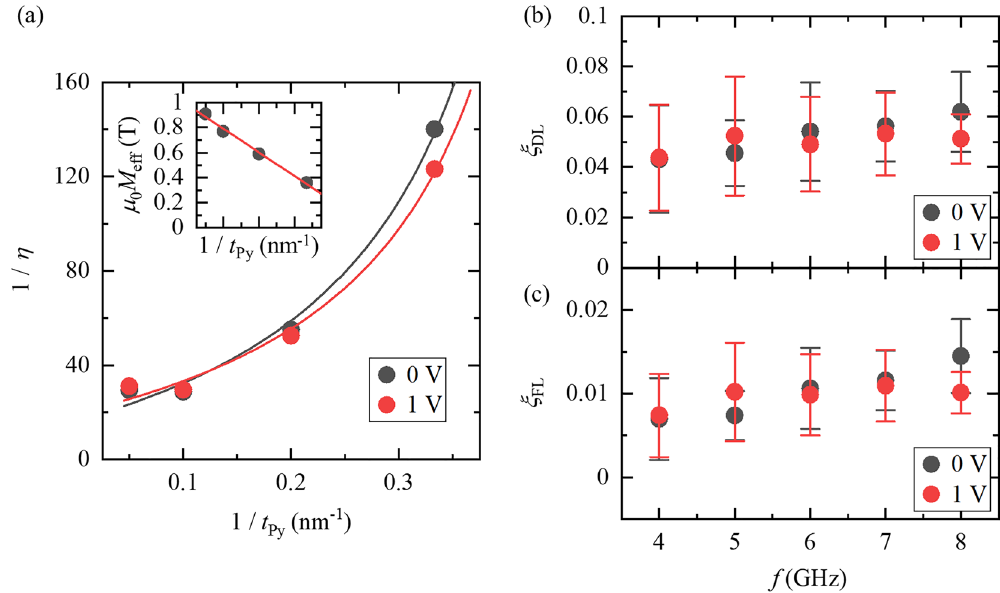
Figure 4. Estimation of damping-like torque and field-like torque. ( a ) Gate voltage dependence of the relationship between the inverse of the Py thickness t Py and the spin-torque efficiency, η . The inset shows the Py thickness dependence of the saturation magnetization, μ 0 M S . Frequency and gate voltage dependences of ( b ) damping-like torque, ξ DL , and ( c ) field-like torque, ξ FL . The black and the red closed circles in all figures are the results at gate voltages of 0 and 1 V,